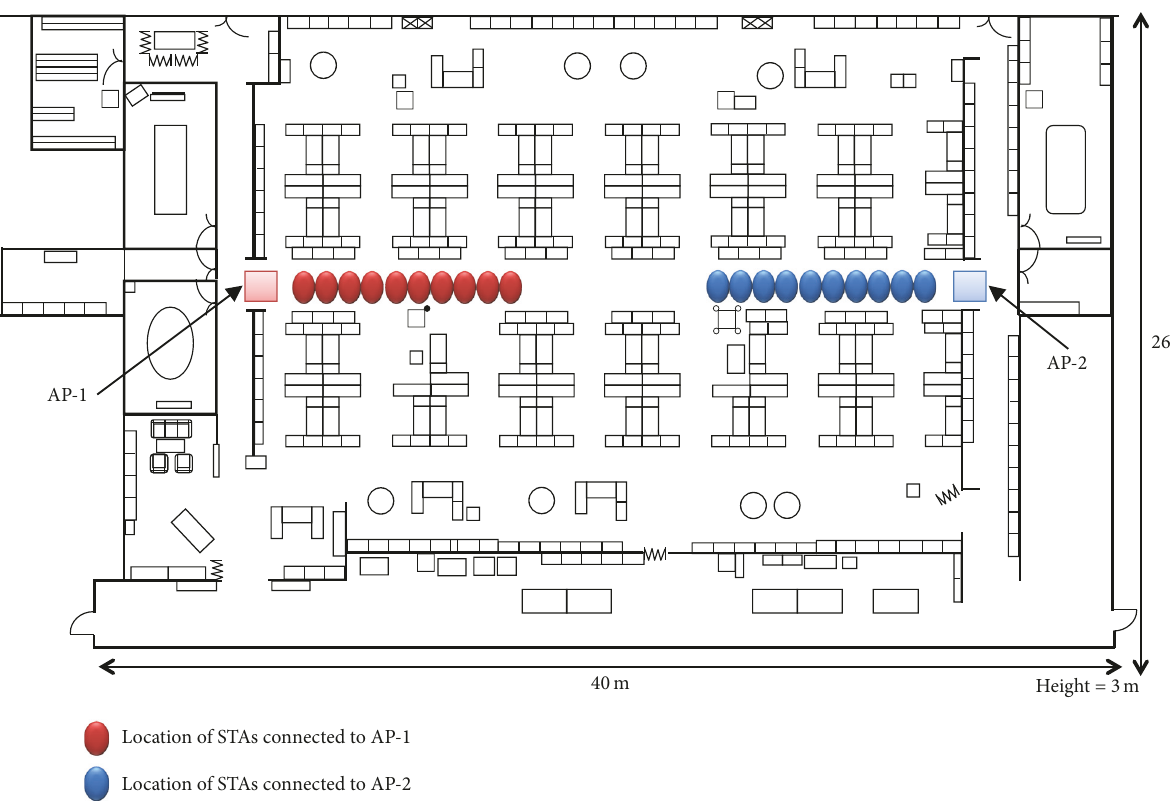
Figure 5: Measurement